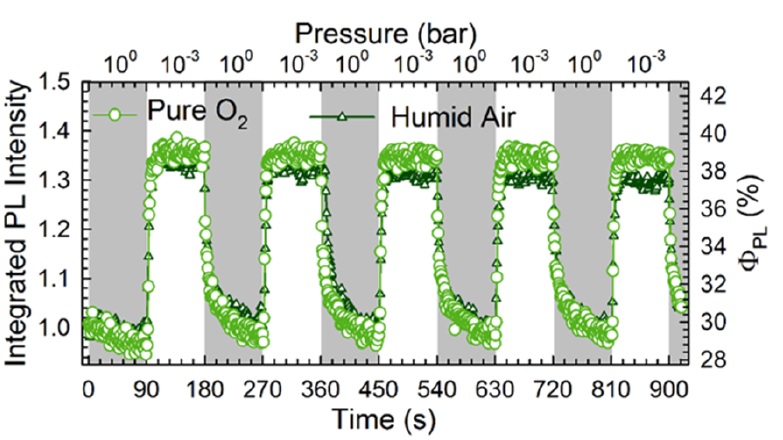
Figure 23. Integrated PL intensity and corresponding PL quantum yield ( Φ PL ) of CsPbBr 3 NCs for O 2 /vacuum and humid air/vacuum cycles between P = 1 bar (gray shades) and P = 10 − 3 bar (white). Adapted with permission from [79]. Copyright © 2017, American Chemical Society. https://pubs.acs.org/doi/10.1021/acs.nanolett.7b01253. Further permission should be directed to the